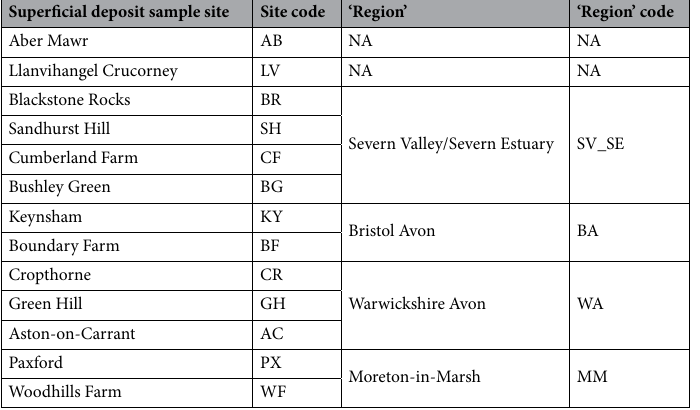
Table 2. Table listing superficial deposit geological sample sites used in this research (based on Elliot